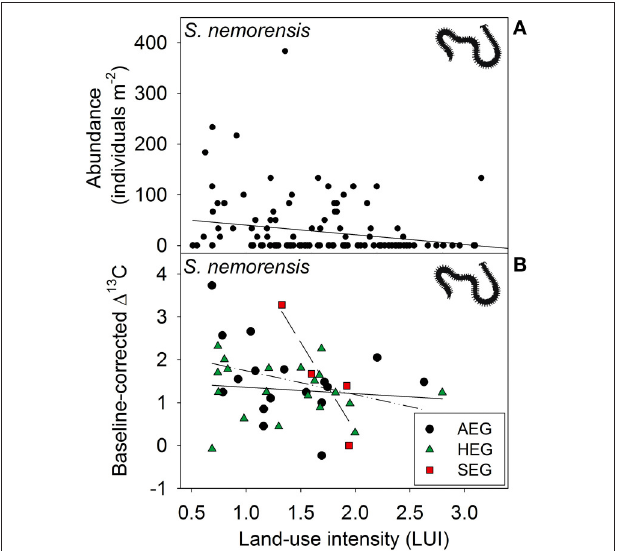
FIGURE 3 | Relationship between land-use intensity and the (A) abundance and between land-use intensity per region and the (B) 1 13 C isotope ratio (AEG, dotted and dashed line; HEG, solid line; and SEG, dashed line) in the centipede species Schendyla nemorensis (see Table 1 for location and abbreviation of regions).